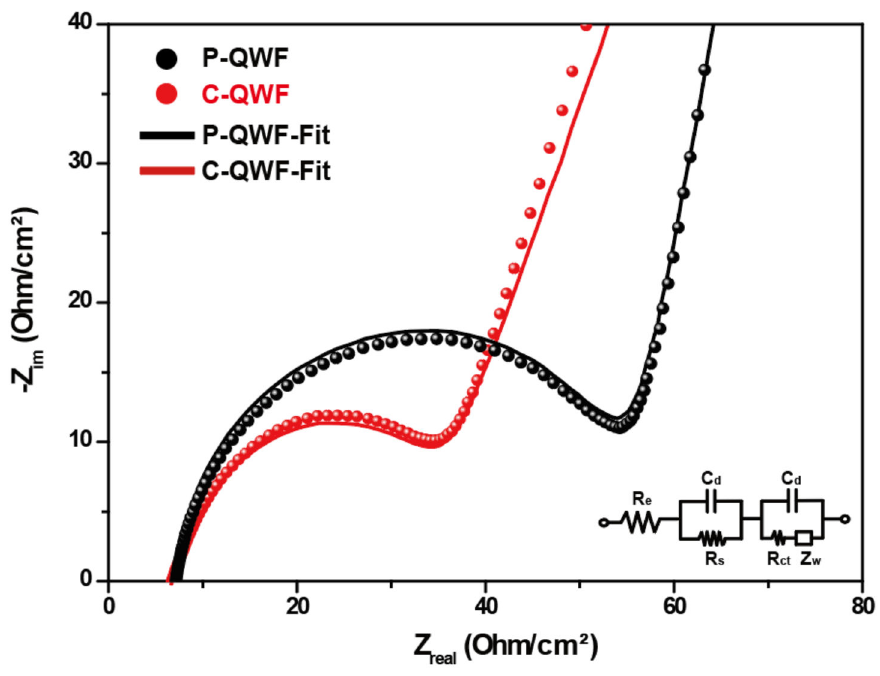
Figure 6. Nyquist plots of P-QWF (60.3 Ω cm − 2 ) and C-QWF electrodes (42.8 Ω cm − 2